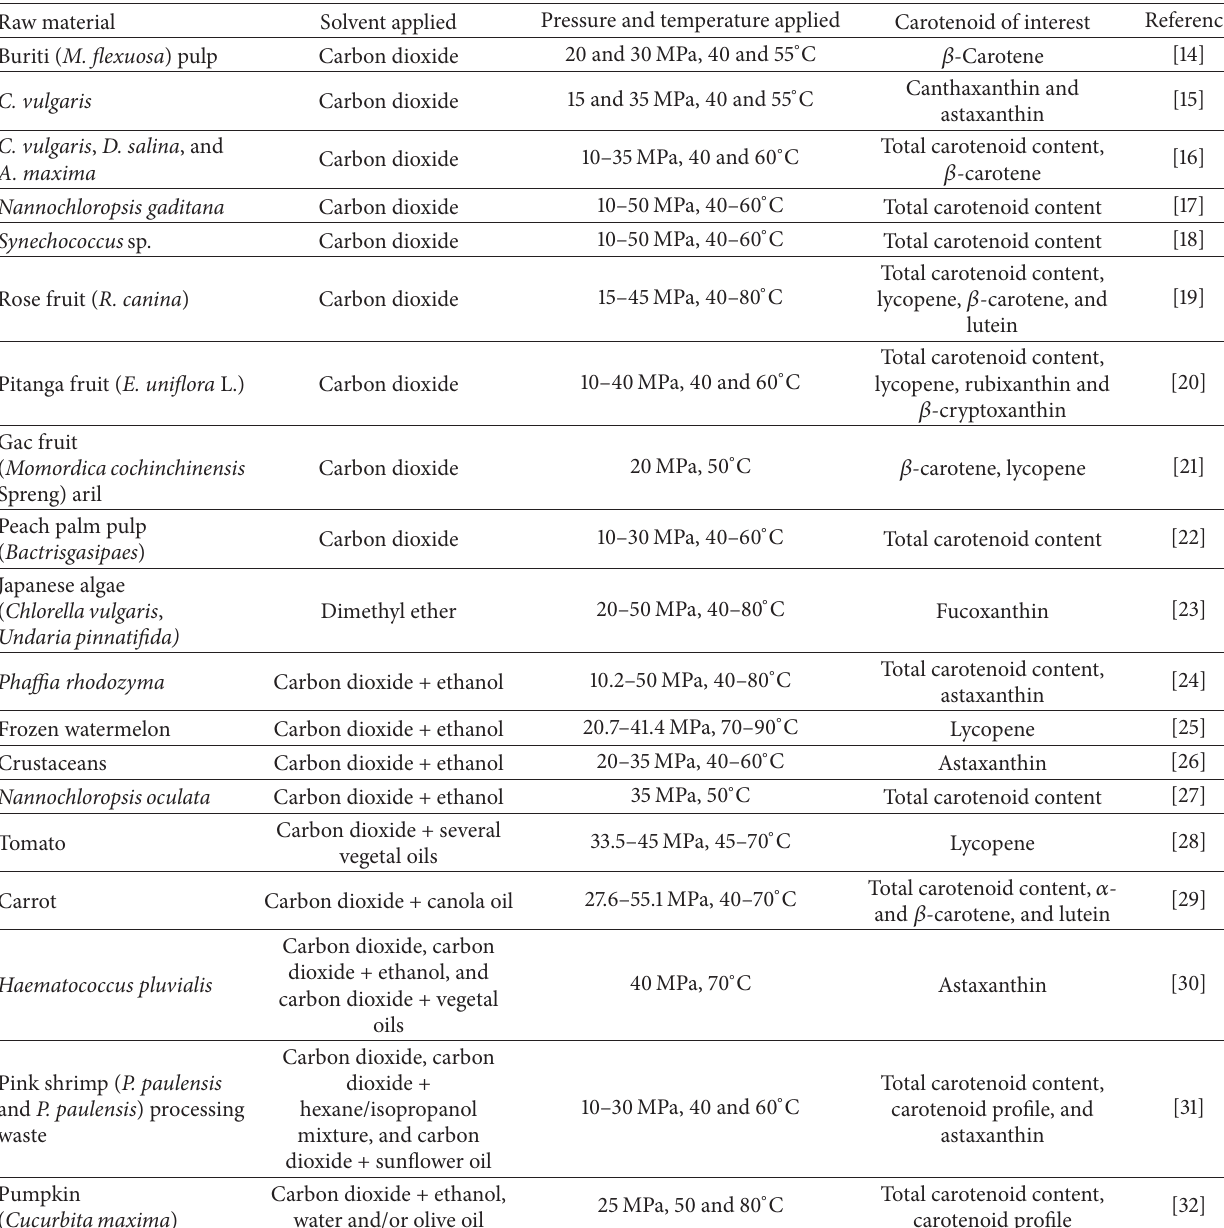
Table 1: Information about recent studies focusing on the supercritical fluid extraction of carotenoids from natural